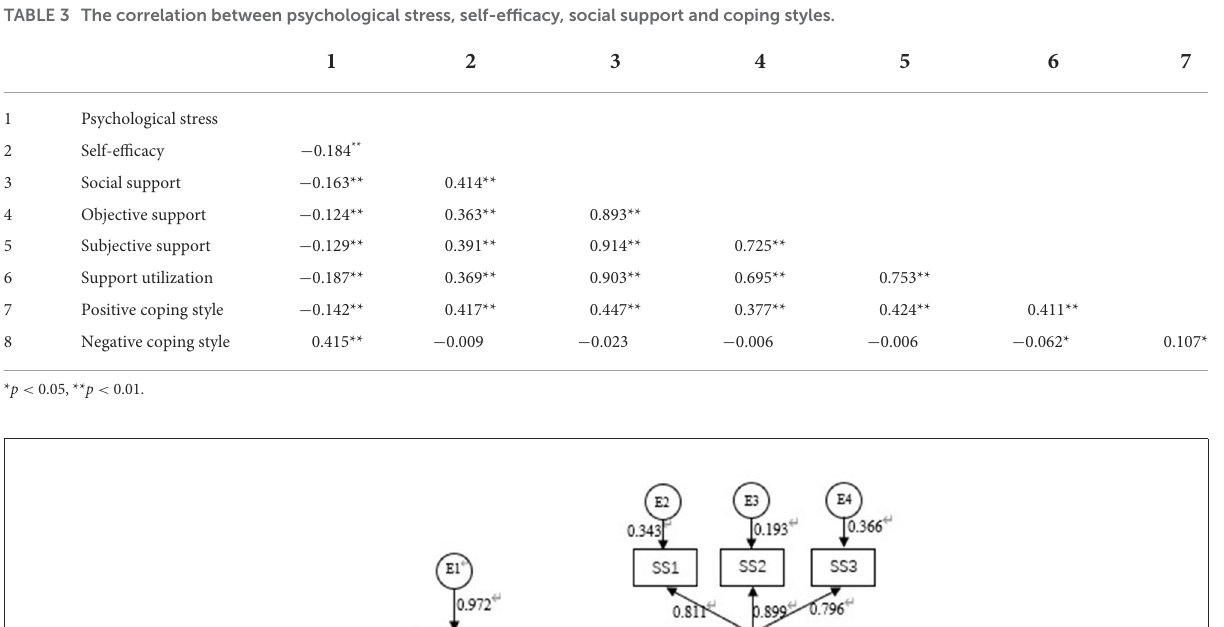
subjective support, (22.04 ± 4.22) for support utilization. The score of positive coping style was (37.14 ± 5.89), and for negative coping style was (14.53 ±